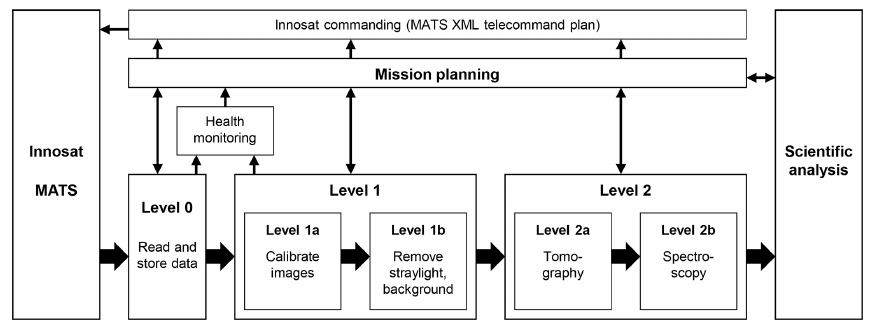
Figure 7. Overview of the data processing steps for the MATS limb